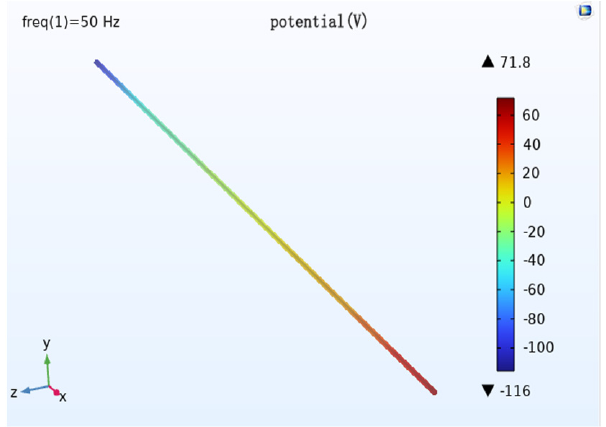
Figure 10. Distribution of cathodic protection potential at voltage level 500 kV.